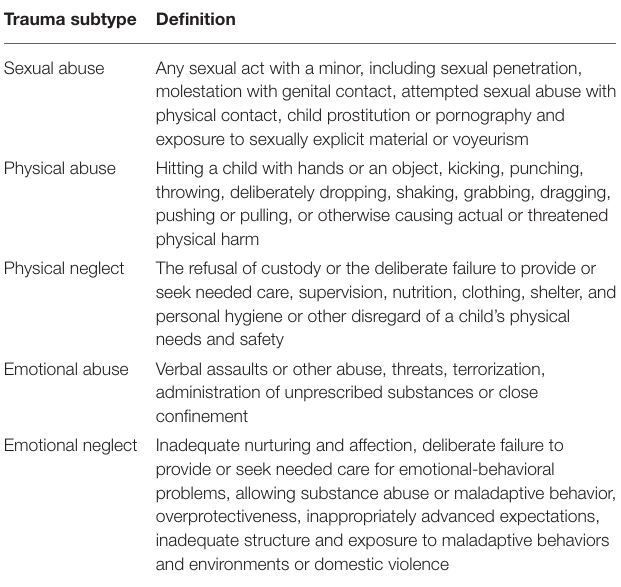
TABLE 1 | NIS-4 criteria for childhood trauma